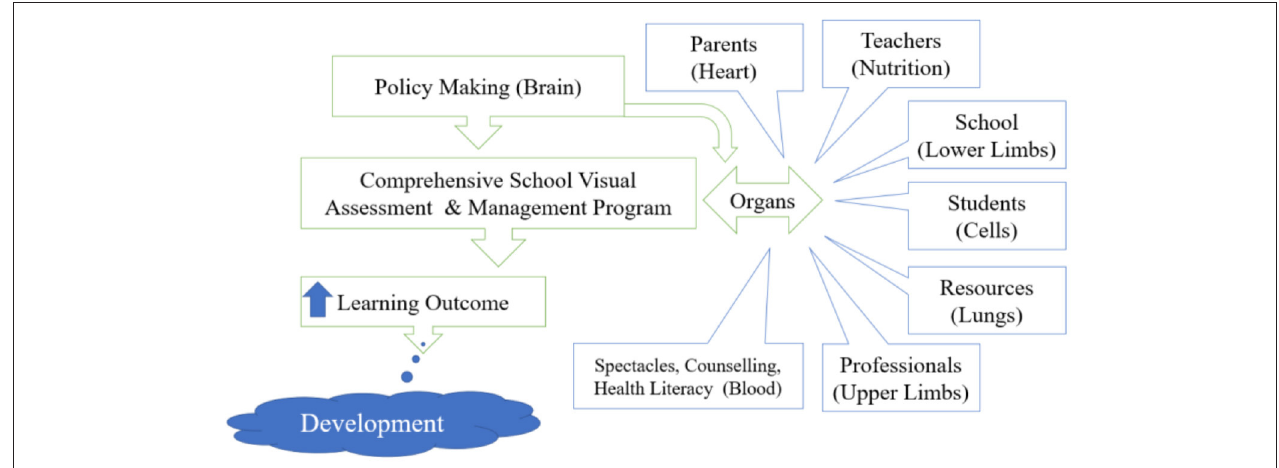
FIGURE 3 | Proposed model for the Comprehensive School Eye Care Program